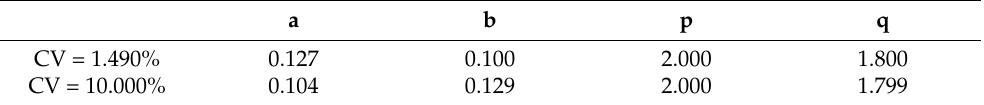
Table 3. Comparison the parameter values of the optimal model and the simulated limit model.